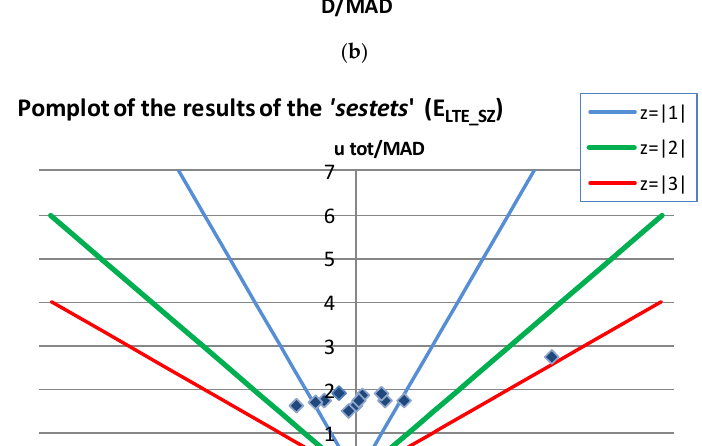
CP . ( b ) E LTE_RS . ( c )